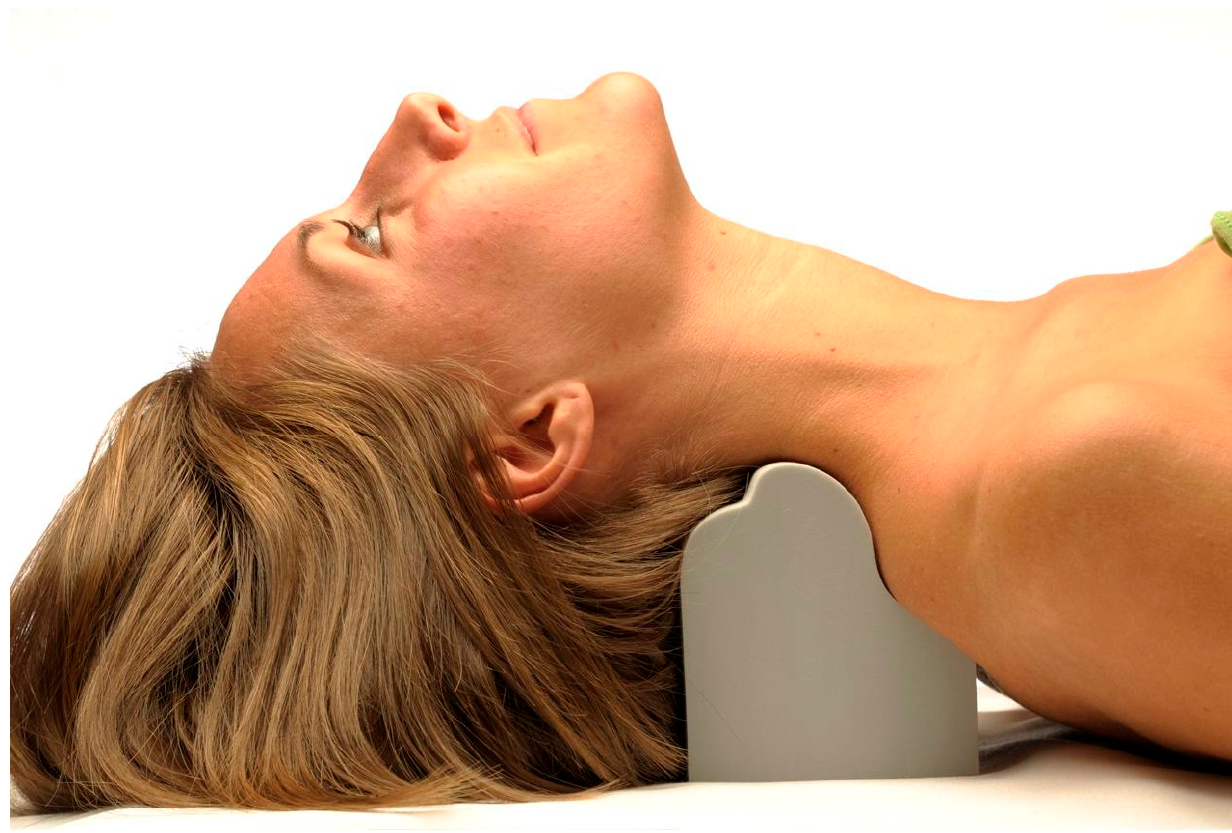
Figure 2. The Denneroll cervical traction orthotic. The participant must lie on a firm surface, such as the floor, and place the peak of the Denneroll just distal to the apex of their cervical lordotic abnormality as shown on the lateral cervical X-ray. Shown is a mid-cervical spine placement. ©Copyright CBP Seminars. Reprinted with permission.